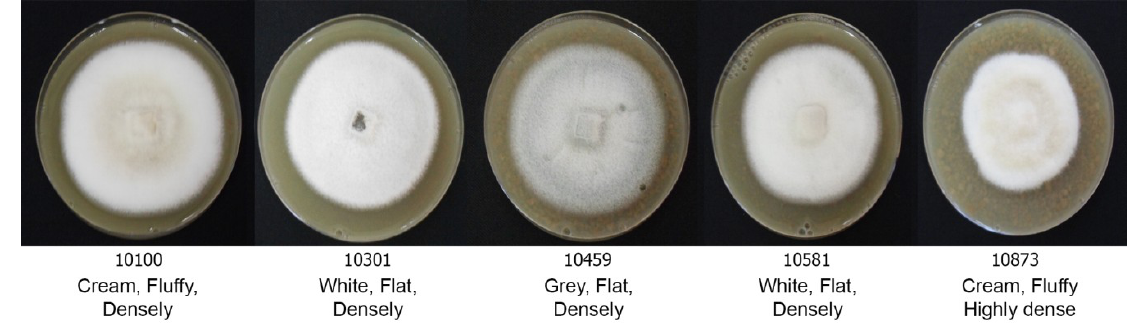
Figure 1. Variation in morphology of Pyricularia oryzae mycelia on the rice flour agar (RFA) medium, showing differences in colors and mycelial growth patterns.